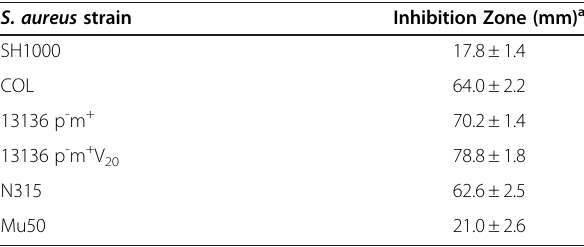
Table 1 Inhibitory effect of terpeneless cold pressed Valencia orange oil (CPV) against S. aureus strains determined by a disc-diffusion vapor